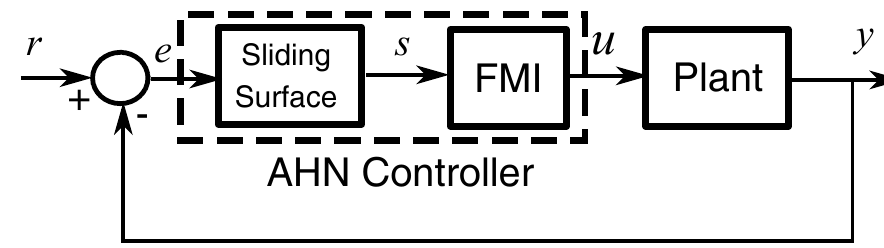
Figure 4. Block diagram of the AHN controller.